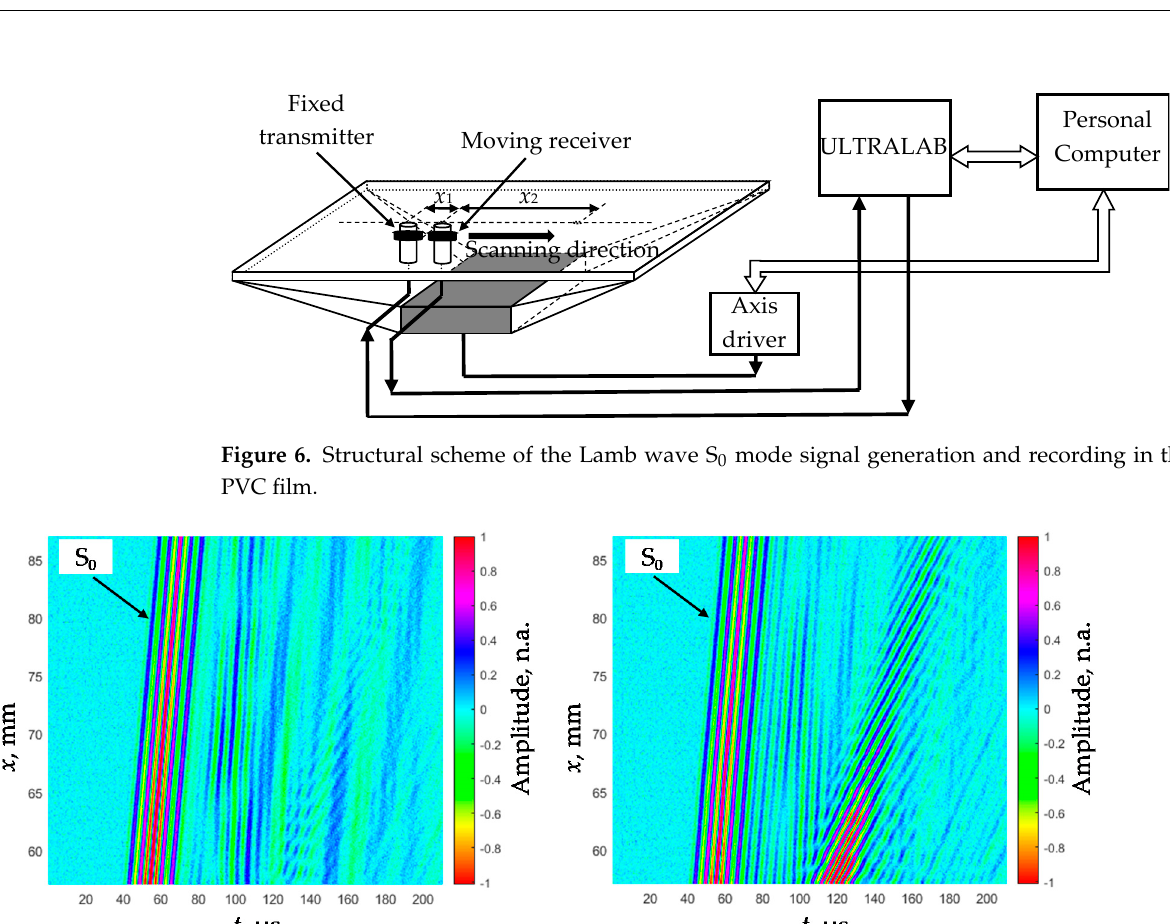
Figure 8. Structural scheme of the Lamb wave A 0 mode signal generation and recording in thin PVC film.